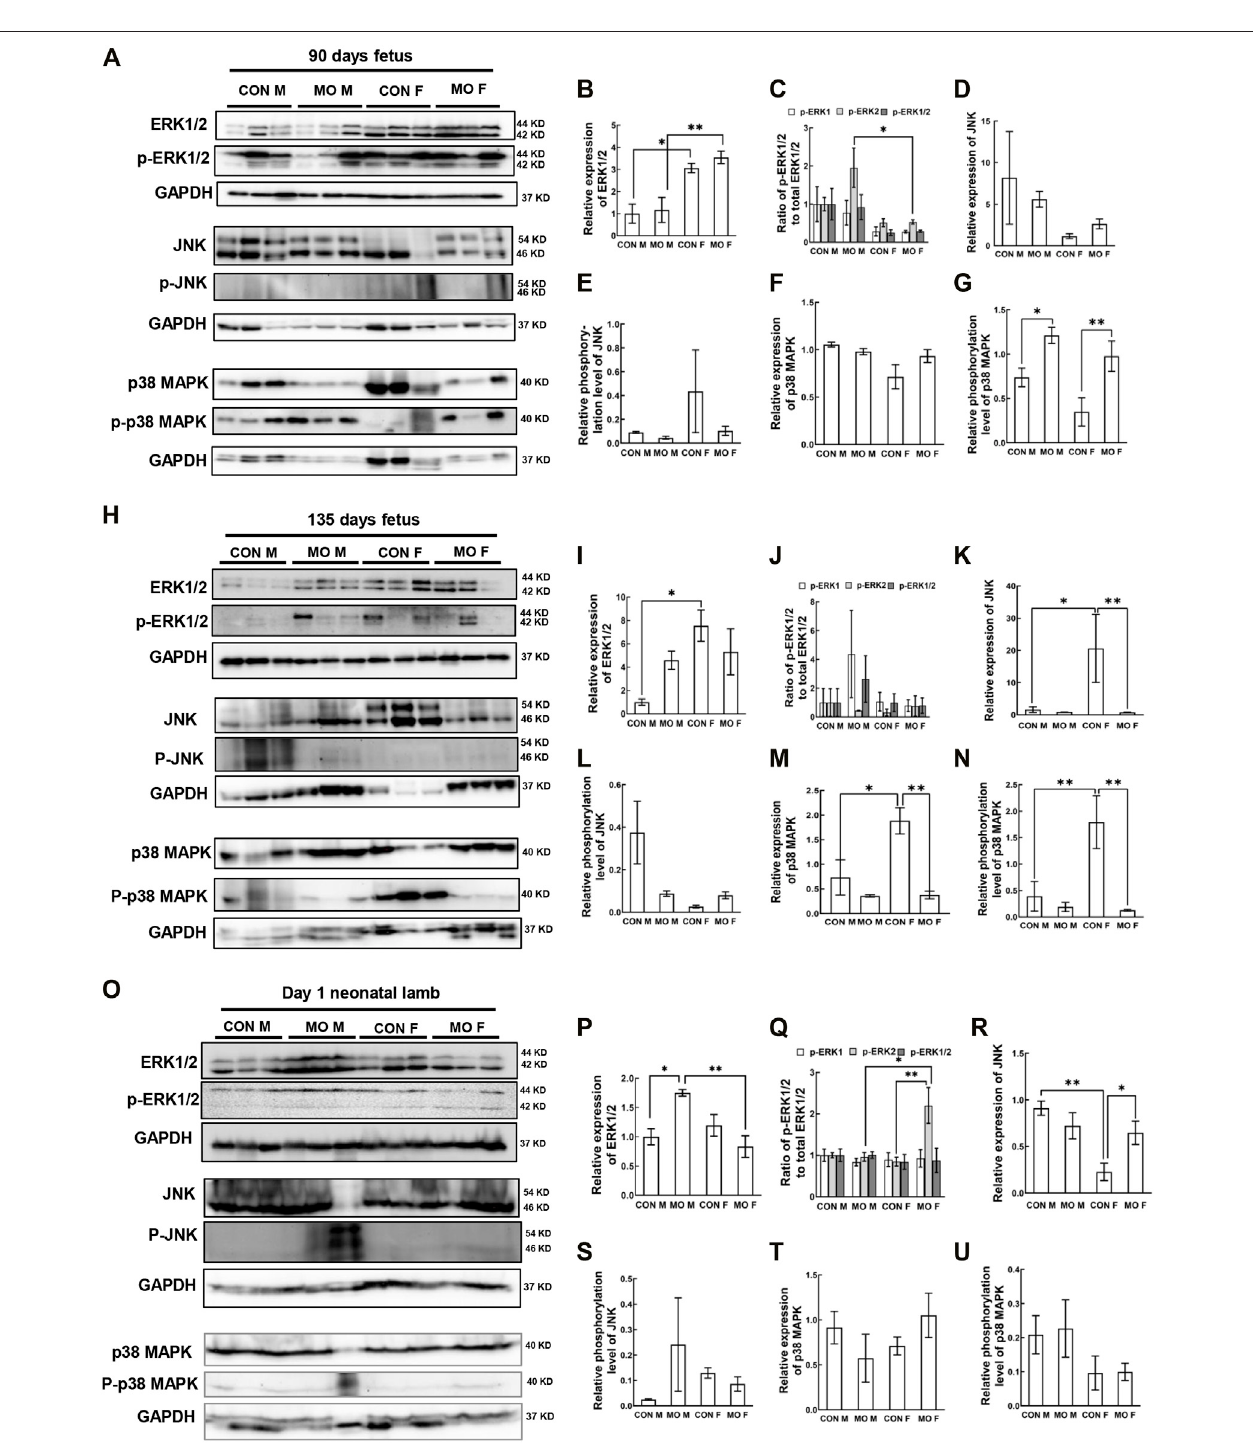
FIGURE 1 | Alteration of MAPK/ERK signaling pathway in offspring heart of overfed ewes at two gestational and one early postnatal time point. (A – G) . Relative expressionandphosphorylationlevelofhallmarkproteinsinfetalheartatmid-gestationday90; (H – N) .Relativeexpressionandphosphorylationlevelofhallmarkproteins in fetal heart at late-gestation day 135; (O – U) . Relative expression and phosphorylation level of hallmark proteins in neonatal heart at day 1 after birth; GAPDH, Protein loading control. CON, control, MO, maternal obesity, M, male, and F, female. Mean ± SEM ( n (cid:1) 5); * p < 0.05, ** p < 0.01.